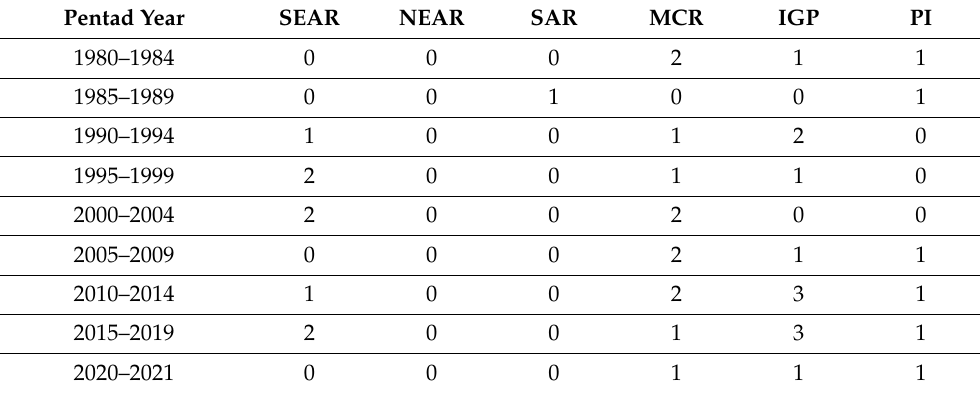
Table 13. Rice suitable climate score for various rice growing regions of the world in pentad years from 1980 to 2021.